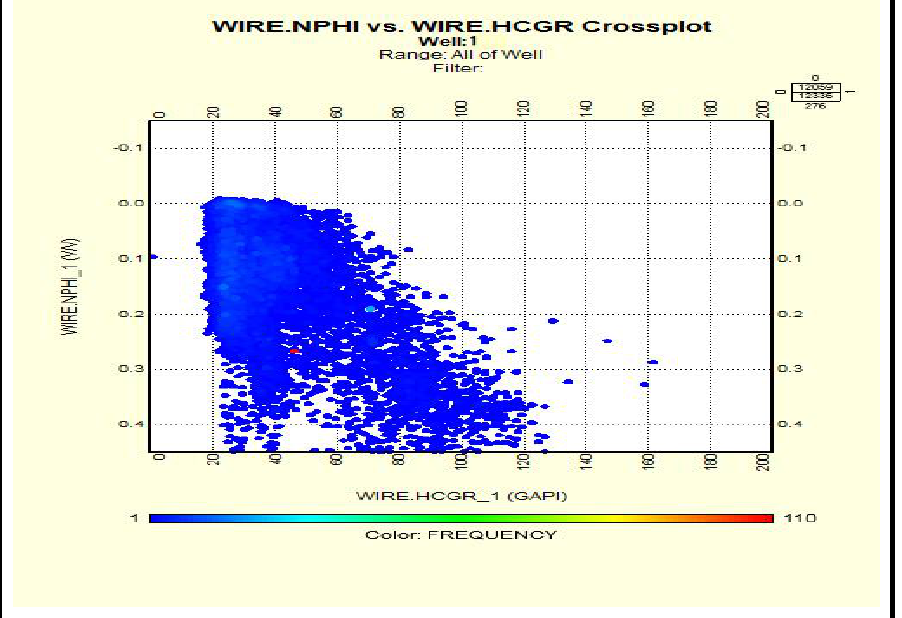
Figure 5. CGR cross-plot against NPHI for well one Yaran oil field: In distances with shale, shale process line indicates the rising of neutron porosity degree and is the amount of Gamma-ray, otherwise, with raising the shale, the porosity will also rise, but this porosity is microscopy. 4- In the deep of 2854-2978 m at this output a concentrated part of limestone with zero porosity exist that doesn’t generally have reservoir